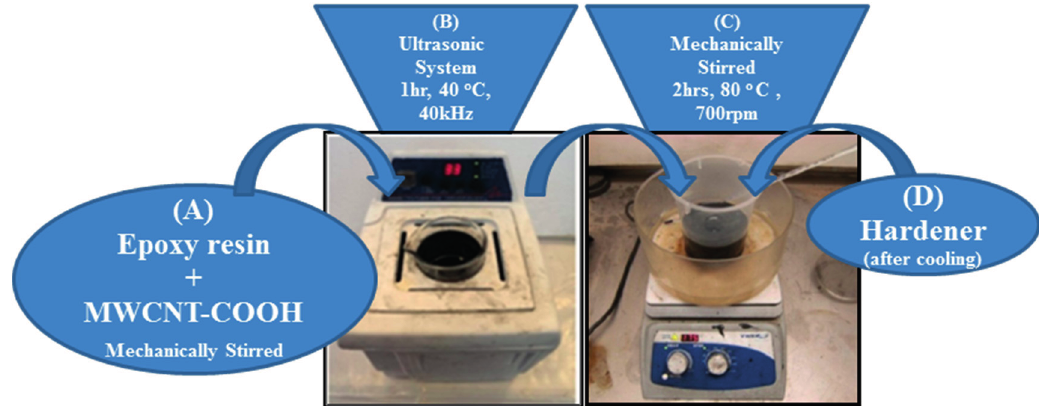
Figure 2. An outlined process for the dispersal of COOH–MWCNTs in